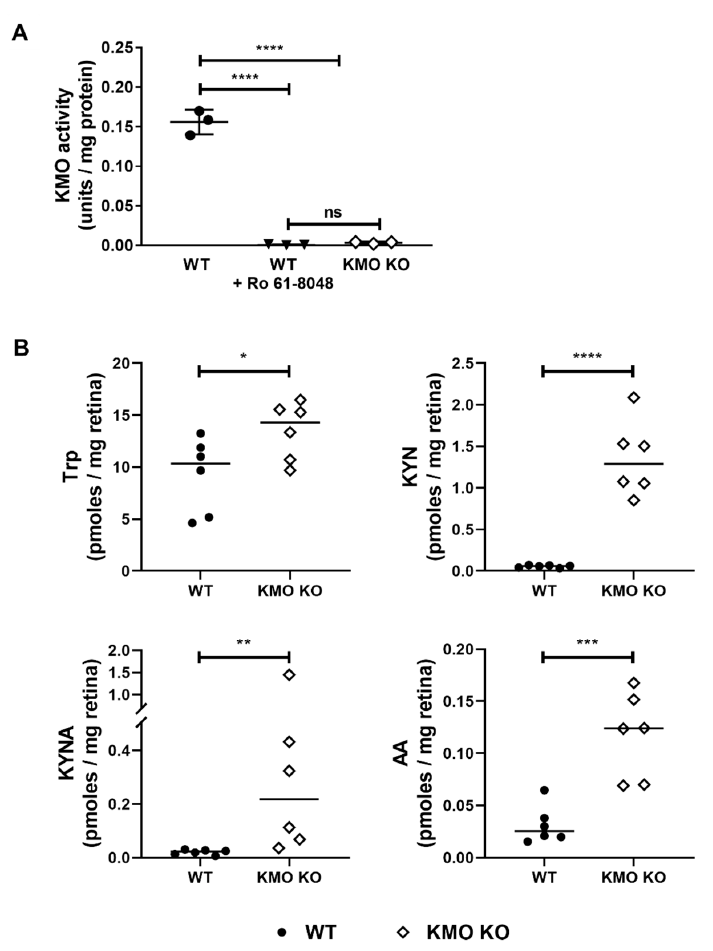
Figure 3. KMO activity was present in wild type (WT) but not in KMO knockout (KO) mice, and